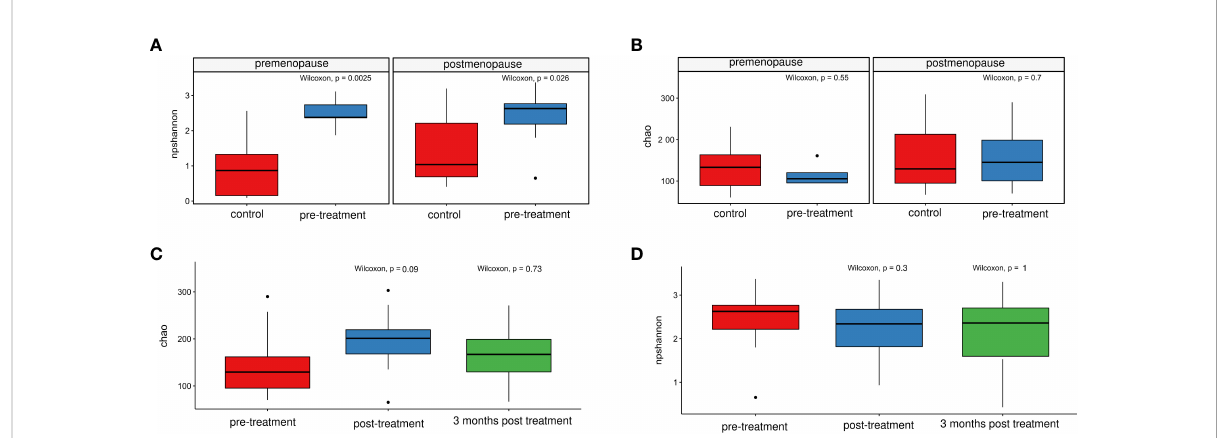
FIGURE 5 Comparison of the non-parametric Shannon indices for healthy controls and patients before treatment. (A) and for patients before and after treatment, and at 3/6 months post-treatment (C) Chao index- comparison in healthy controls and patients before treatment (B) and in patients before and after treatment, and at 3/6 months post-treatment (D) .